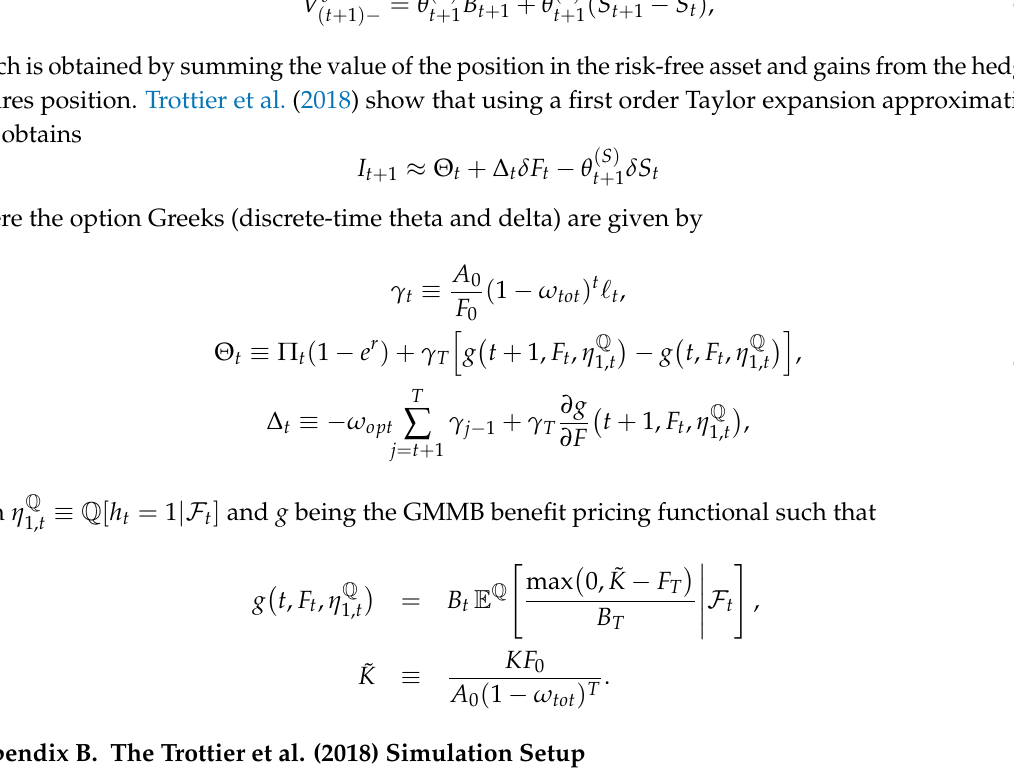
Table A1. Policyholders aged 55 years at time t = 0 purchasing an at-the-money GMMB segregated fund with a 10-year maturity ( T = 120) are considered. Survival probabilities are obtained using the Canadian Institute of Actuaries’ recommended methodology; base mortality rates are drawn from the CPM2014 table, see CIA (2014). Mortality improvements are projected with rates proposed in Appendix C of CIA (2010). Monthly mortality rates are obtained from annual rates by assuming a constant force of mortality throughout the